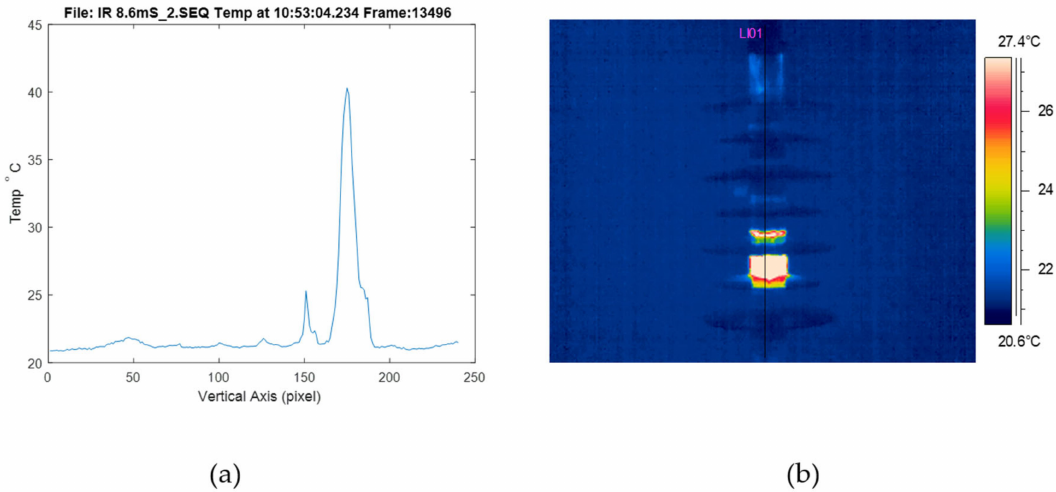
Figure 14. Temperature profile and DB evolution for heavy pollution at 30 kV rms ( a ) temperature profile ( b ) IR